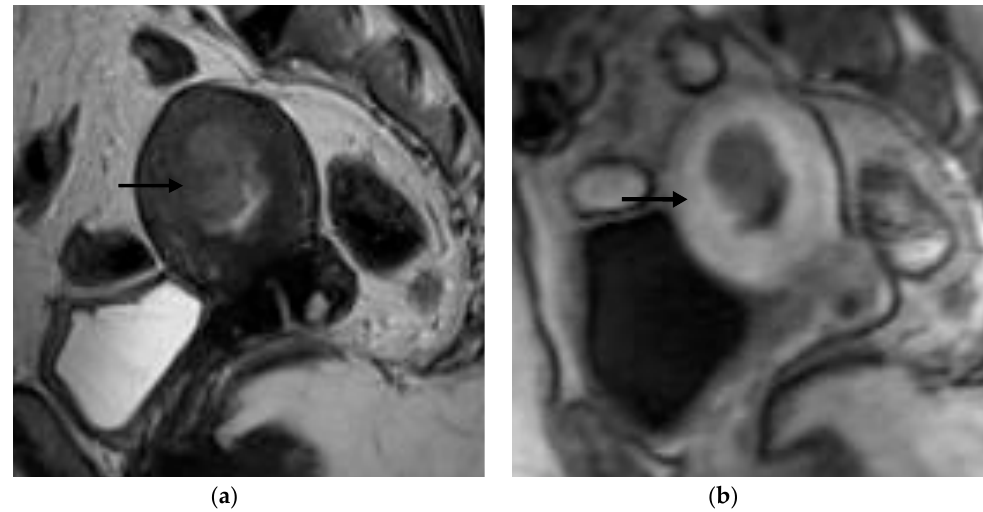
Figure 3. Representative MRI images of endometrial carcinoma of a false-negative case in a 50-year-old postmenopausal woman. ( a ) Sagittal T2WI MRI image shows a hyperintense lesion with blurring of the junctional zone (arrow). ( b ) DCE-MRI image shows a hypointense lesion with irregularity of the subendometrial enhancement (arrow) and <50% myometrial invasion. However, the histopathological result revealed ≥ 50% myometrial invasion.